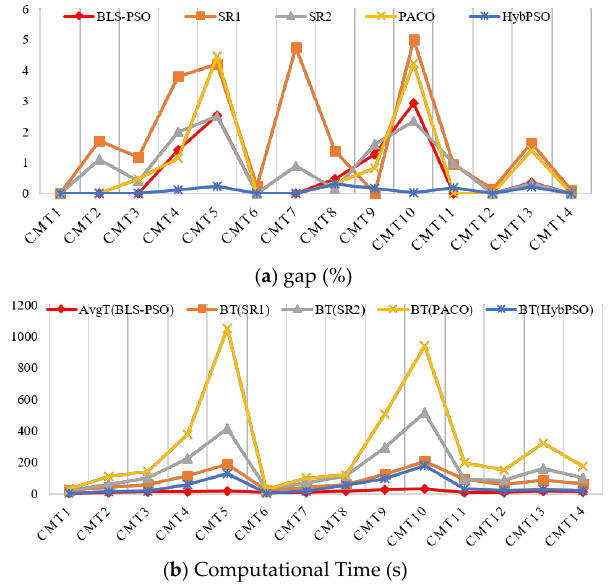
Figure 8. Performances of different algorithms in solving Set CMT instances. ( a ) gap (%); ( b ) Computational Time (s).